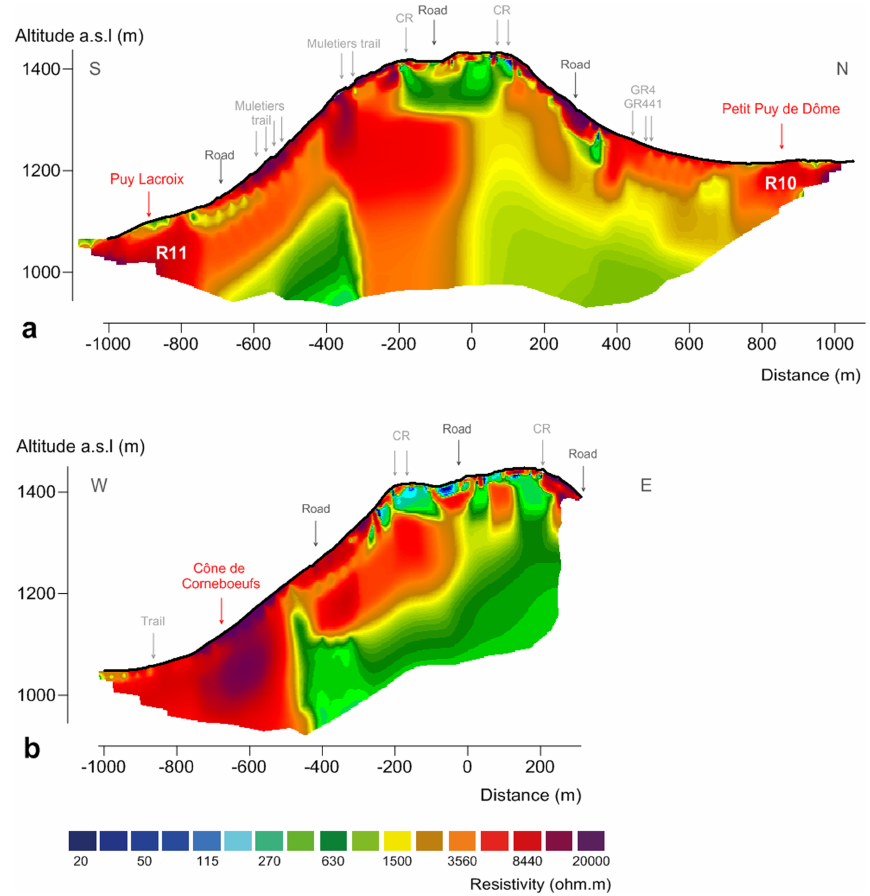
Fig. 3. 2-D resistivity models: (a) north–south direction; (b) west–east